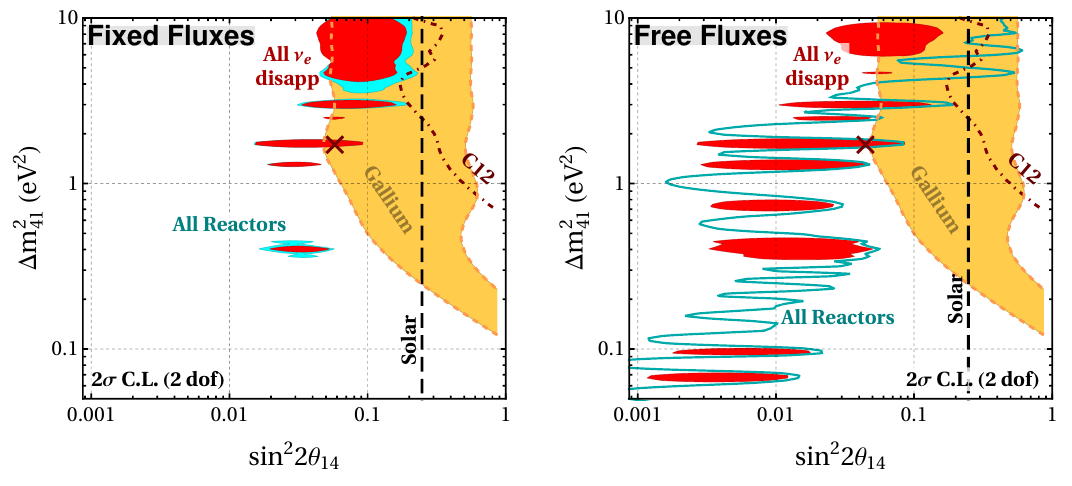
Figure 5 . Allowed parameter regions at 2 (cid:27) (2 dof) for the \(cid:12)xed (cid:13)uxes" (left) and \free (cid:13)uxes" { ) (right) analyses, for all ( (cid:23) e disappearance experiments (red shaded regions). The global best (cid:12)t point is marked with a cross. In addition we show the regions or bounds obtained from combined reactor data, the radioactive source experiments, (cid:23) e scattering on 12 C, and solar